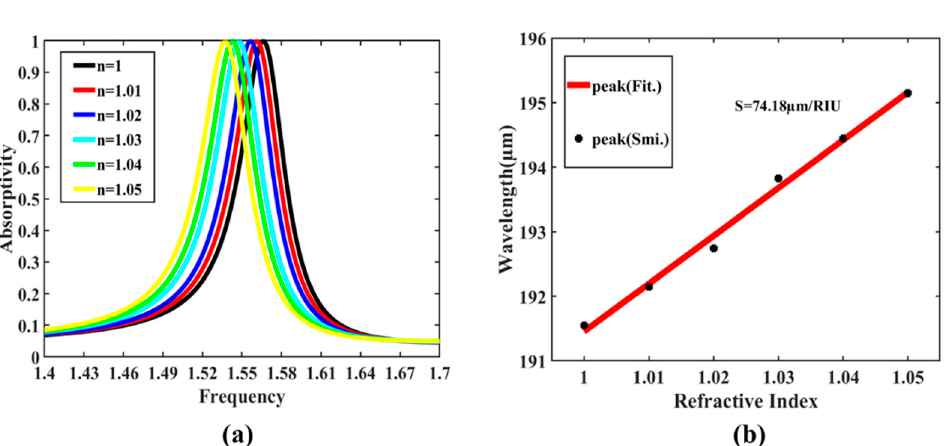
Figure 4. ( a ) The absorption spectra of the structure with different n . ( b ) The simulated resonant linear fit are functions of different ∆ n . wavelength shift and the linear fit are functions of different Δ n .